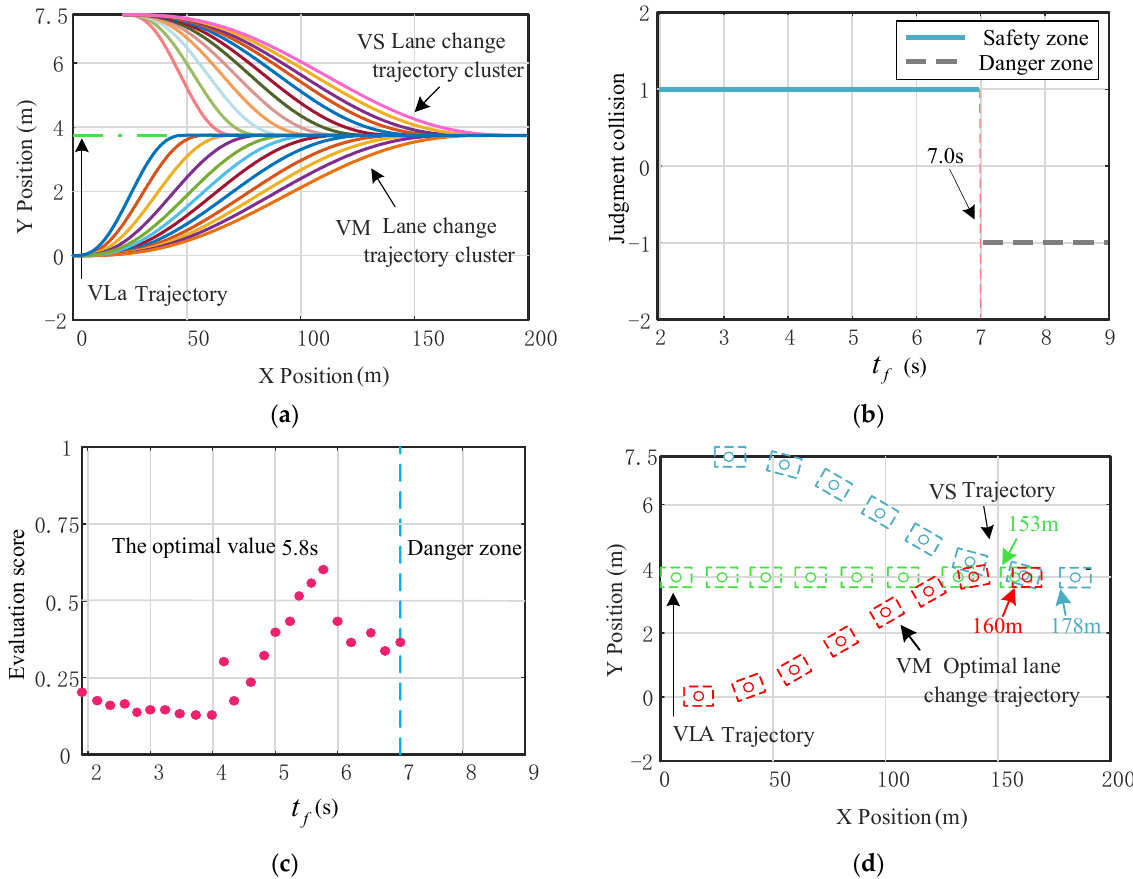
Figure 12. ( a ) Lane change trajectory cluster and Lag trajectory of Subject and Separate vehicle; ( b ) Results of the safe collision avoidance algorithm; ( c ) Results based on Topsis algorithm scores; ( d ) Optimal lane change trajectory for the subject vehicle.